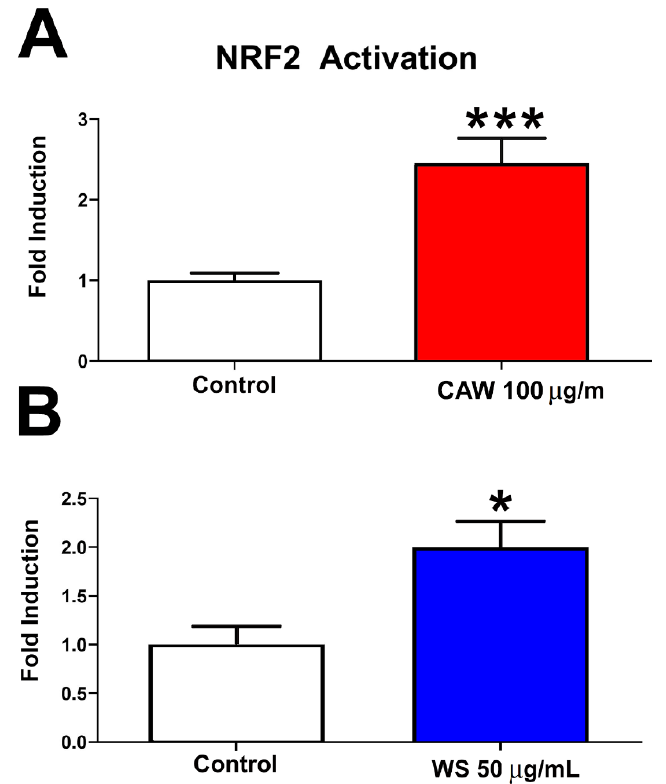
Figure 1. NRF2 activity in the presence and absence of W. somnifera water extract (WS) or C. asiatica water extract (CAW). HepG2-ARE cells treated with CAW ( A ) WS ( B ) showed a significant increase in NRF2 activity compared to controls (* = p < 0.05, *** = p < 0.001). Eighteen independent measurements over 3 replicate experiments were performed. Error bars represent standard error of the mean.